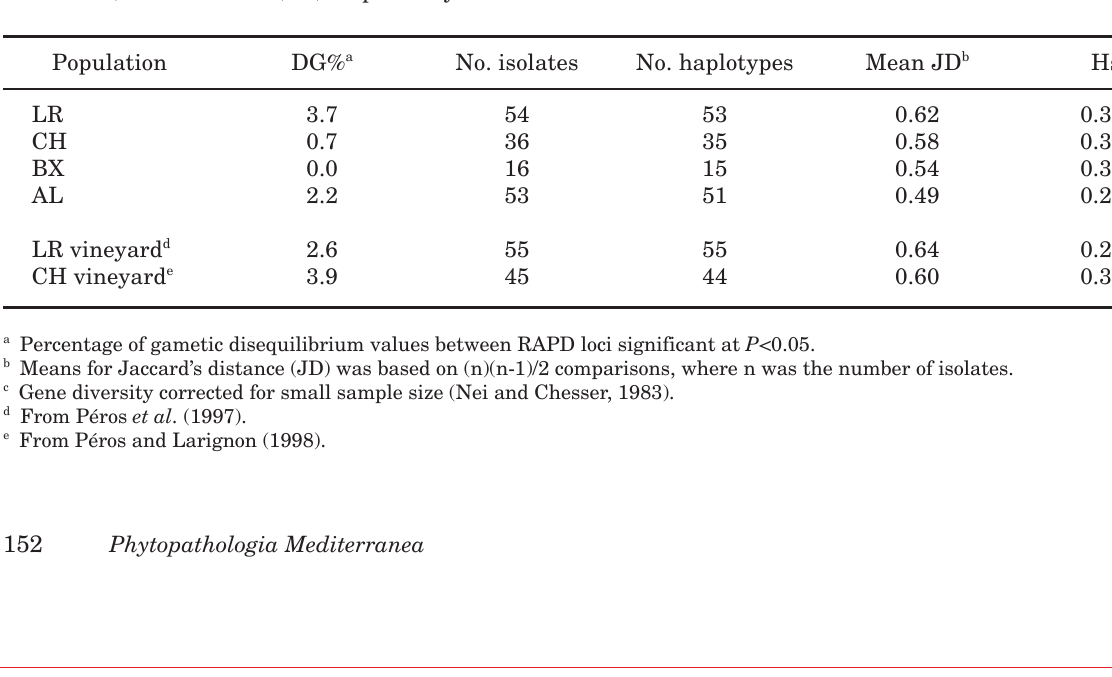
Table 3. Genetic structure of six populations of Eutypa lata sampled in Languedoc-Roussillon (LR), Charentes (CH), Bordelais (BX and Alsace (AL)